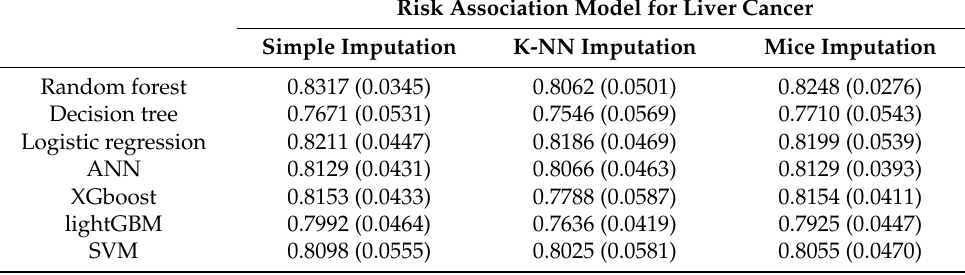
Table 4. Average AUC values for each combination of the liver cancer risk association model and missing value imputer. Standard deviation is calculated in the